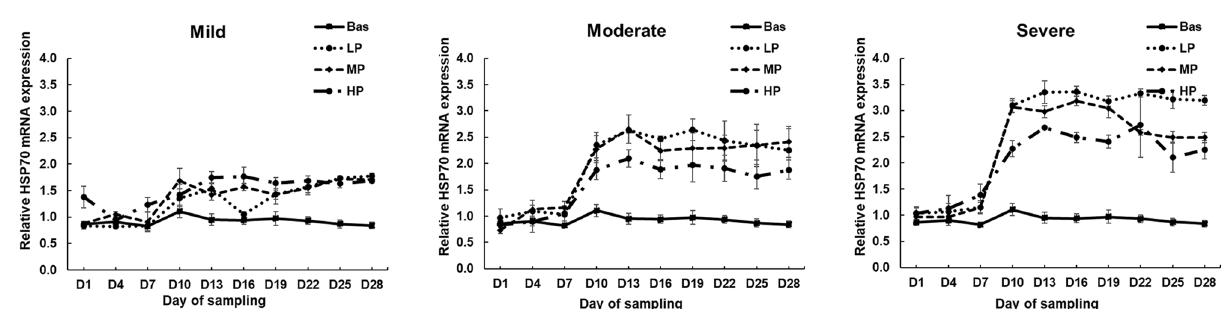
Figure 4. Effects of dietary protein levels on the mRNA expression of HSP70 in hair follicles of calves during the climate chamber experiment. The data are presented as the means ± standards error (n = 4/group) (protein: P < 0.05, HS: P < 0.01, day: P < 0.01). Threshold = THI 70 to 73, Mild = THI 74 to 76, Moderate = THI 81 to 83, Severe = THI 89 to 91. LP = Low protein (12.5%), MP = Medium protein (15%), HP = High protein